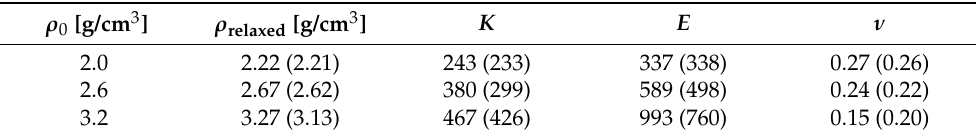
Table 1. Density, bulk modulus K , Young’s modulus E and Poisson’s ratio ν of the a-C samples used in this study as obtained by the presented force field and by the screened REBO2 potential (in brackets). ρ 0 refers to the density after the constant-volume quenching, ρ relaxed is the density when the atomic positions and the simulation cell are relaxed to zero pressure. Additional reference data can be found in Ref.